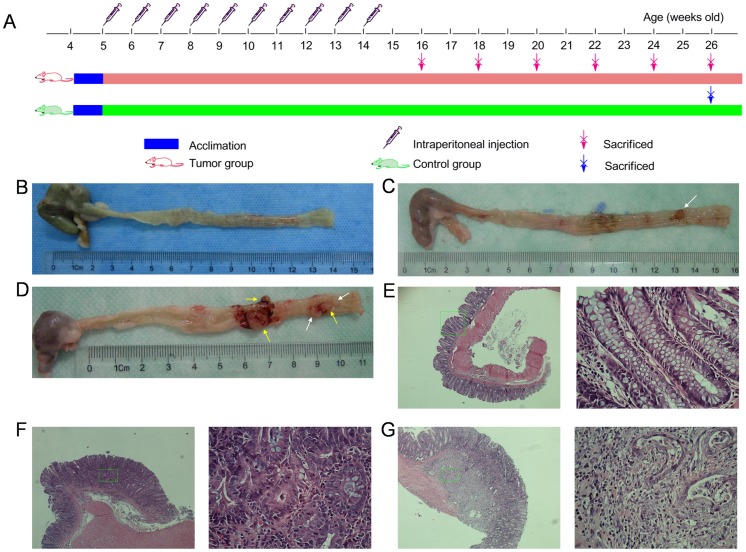
Experimental protocol, representative pictures of colon tumors and photomicrographs showing the pathological characteristic.(A) Experimental procedures. (B) Normal colon. (C) Adenoma (white arrow). (D) Adencarcinoma (yellow arrow). The bloodstain around the tumor was caused by tumor ulcer instead of our dissection. Representative photomicrographs showing the normal mucosa (E), adenoma (F) and adenocarcinoma (G) were magnified in 40×(left), and each of the right micrograph (400x) highlighted the district from the corresponding green rectangle.